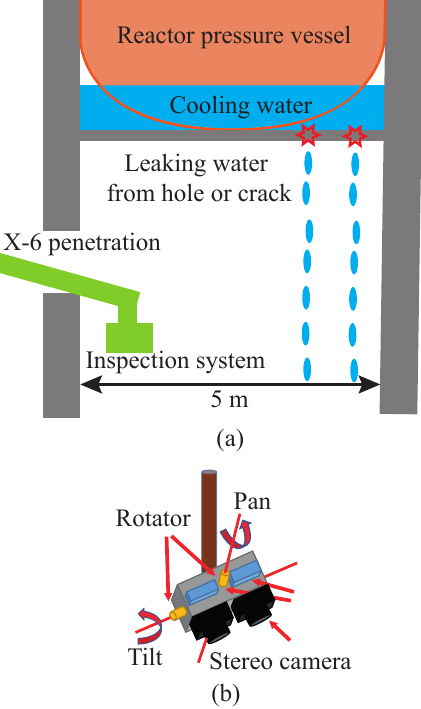
Figure 1. The inspection system inserted into the pedestal below the RPV of Unit 2. ( a ) Pedestal where water leaks from the damaged area. The inspection system is inserted into the pedestal through the X-6 penetration. ( b ) The stereo camera mounted on the inspection system with a rotating